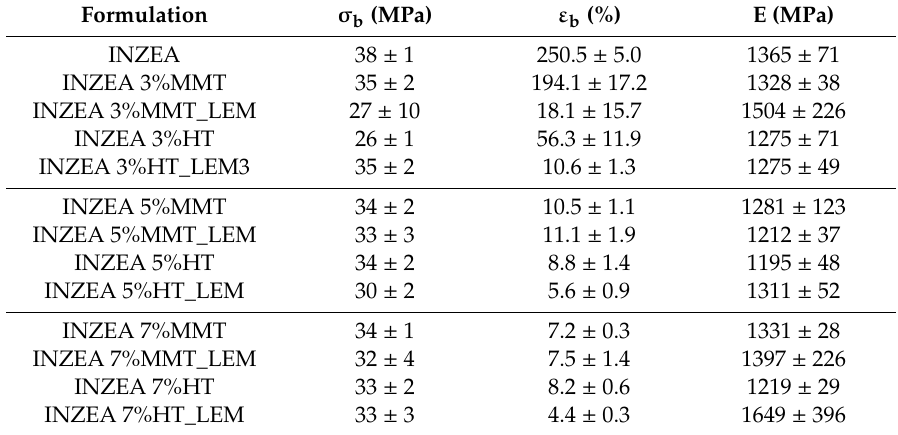
Table 7. Mechanical parameters for INZEA bio-nanocomposites with MMR lemon hybrid pigment (MMT_LEM) and HT lemon hybrid pigment (HT_LEM) nanofillers at 3 di ff erent concentrations (m ± SD; n =